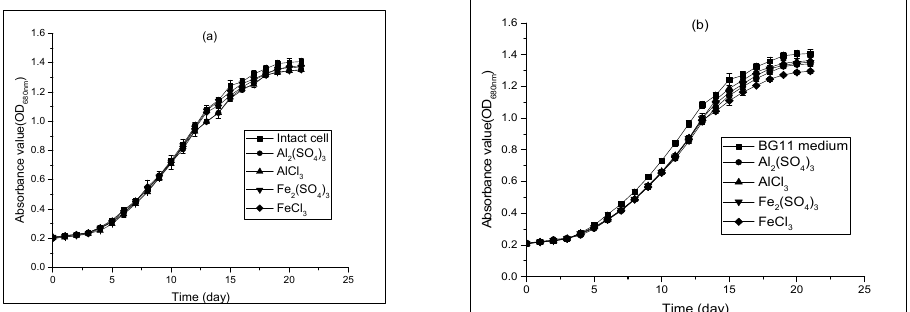
Figure 5. Cell growth curves of ( a ) algal cells in flocs and ( b ) intact cells in spent medium. Data are reported with +/ − SD, and n = 3.